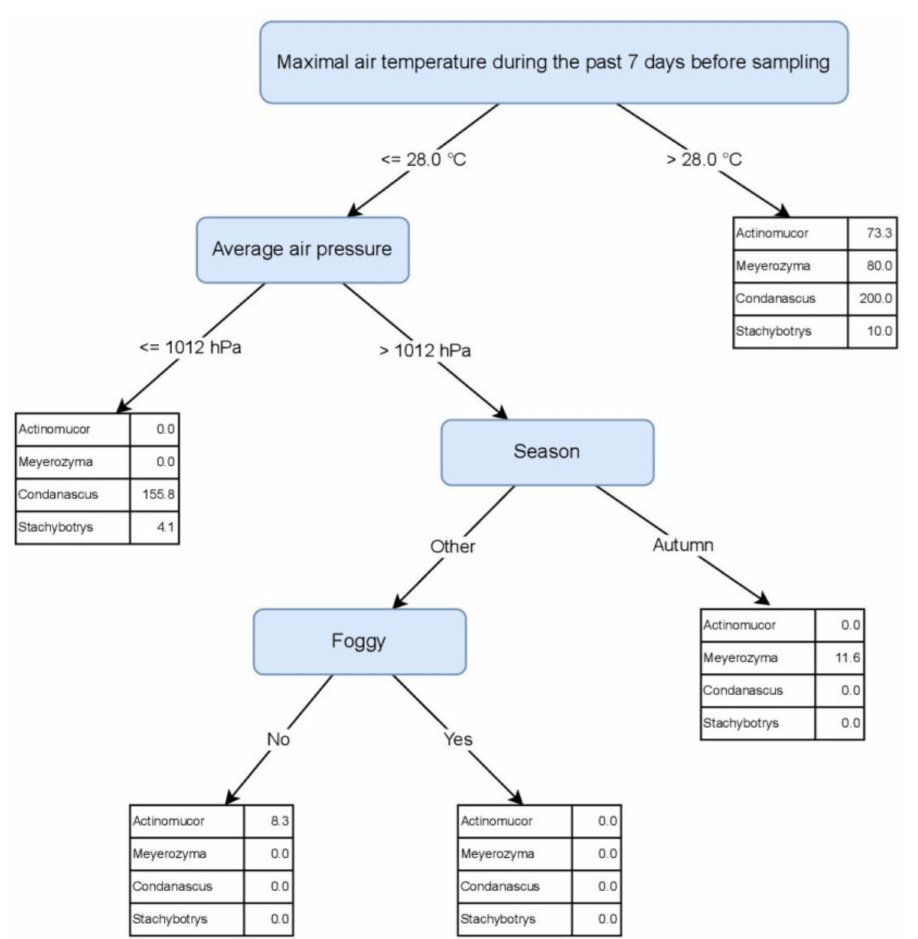
Figure 6. Predictive Clustering Tree (PCT) for multi-target regression (MTR), predicting the abundances of potential human pollution indicators, isolated from beach sand and seawater. For the case when the Maximal air temperature during the past 7 days before sampling is higher than 28 ◦ C, the predicted abundances (CFU/g) are given in the top-most leaf node of the tree ( Actinomucor = 73.3 CFU/g, Meyerozyma = 80.0 CFU/g, Condenascus = 200.0 CFU/g, Stachybotrys = 10.0 CFU/g). If temperature is less than or equal to 28 ◦ C, another test is applied on the Average air pressure attribute. This way, the decision tree is traversed and every sample eventually ends up in one of the leaf nodes of the tree, where predictions for fungal abundances are